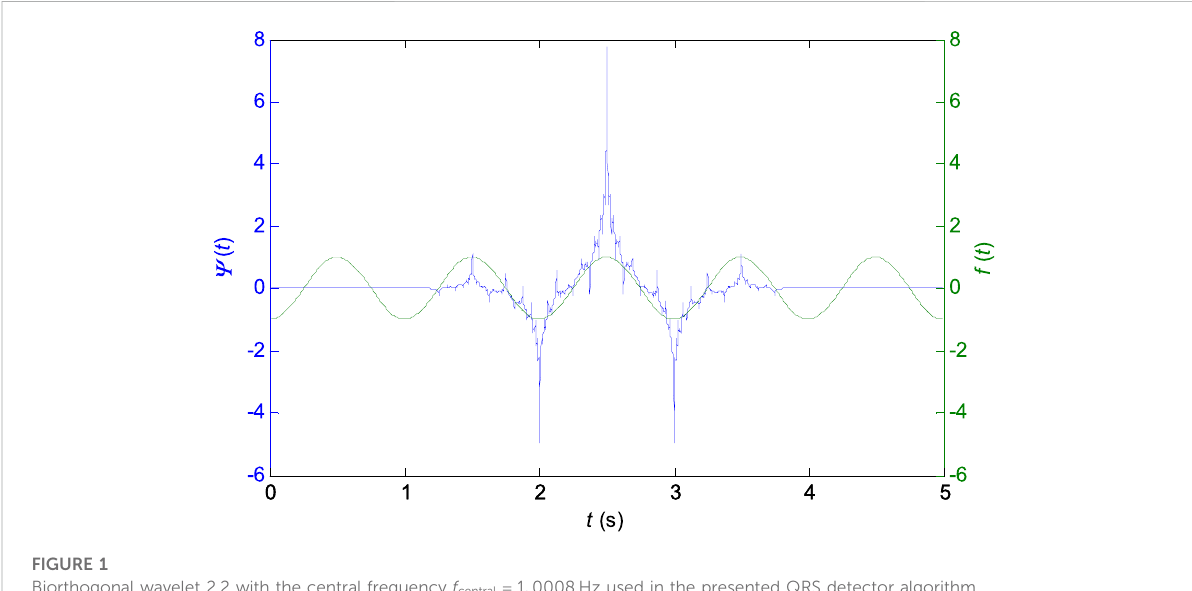
FIGURE 1 Biorthogonal wavelet 2.2 with the central frequency f central (cid:2) 1 , 0008Hz used in the presented QRS detector